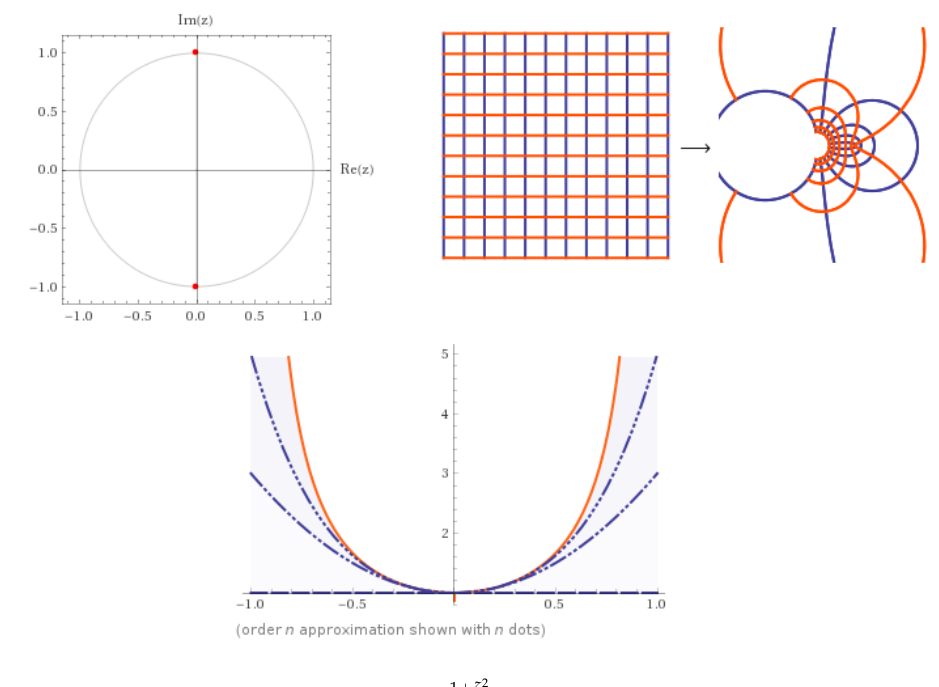
Figure 4. The behavior of Φ ( ζ ) = 1 + ζ 2